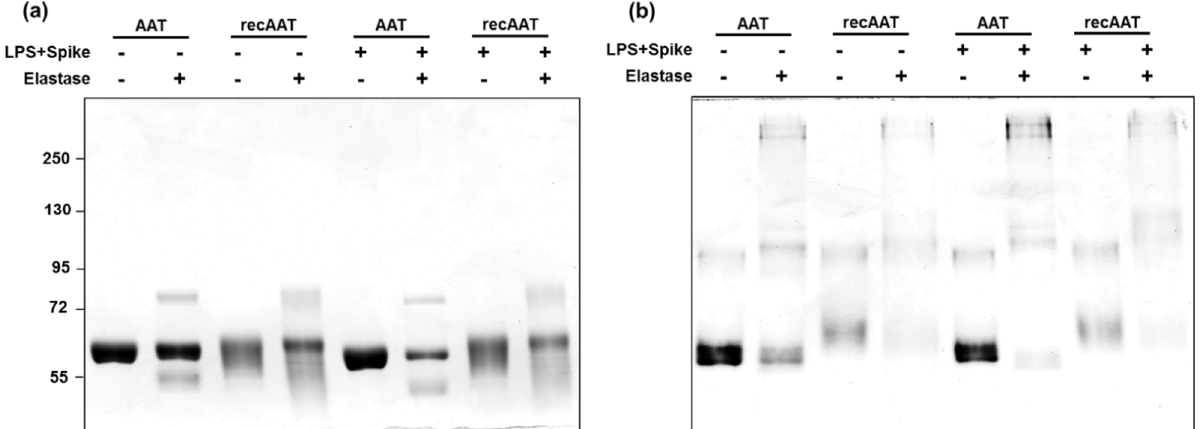
Figure 1. Characterization of plasma-derived AAT and recombinant AAT by elastase complex formation: AAT (0.5 mg/mL) protein was mixed with porcine pancreas elastase in a molar ratio of 2:1 (AAT/elastase). In some cases, 10 ng/mL LPS and 12 µg/mL spike was added. Samples were incubated for 30 min at room temperature. ( a ) Proteins were separated on a 7.5% polyacrylamide SDS gel and ( b ) on a 7.5% native gel in the absence of SDS under non-reducing conditions. The gels were stained with Coomassie. The figure shows representative gels from two independent experiments.